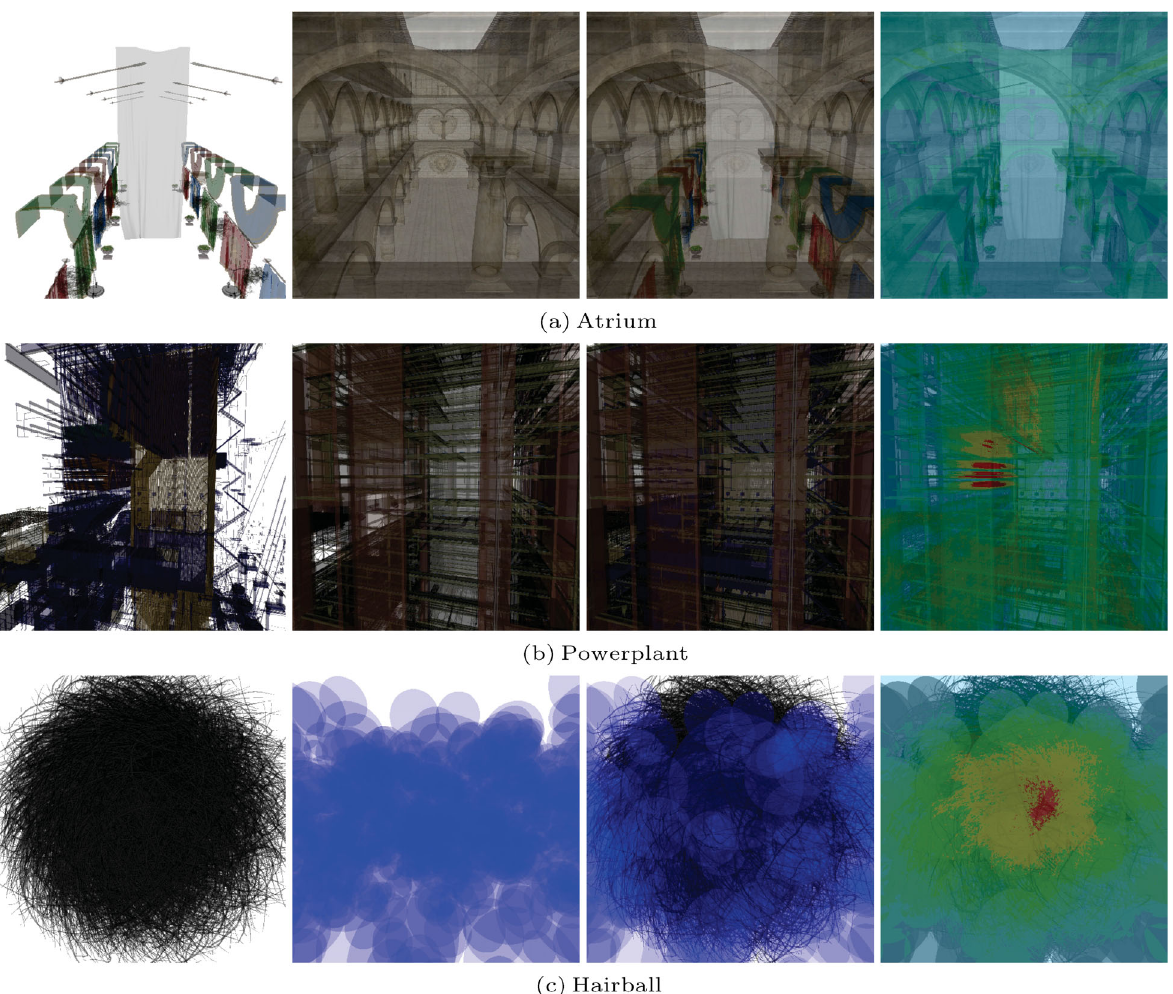
Fig. 8 Test scenes with separated and merged deep images. Heatmap gives depth complexity with blue up to 16 fragments, green 16–64, yellow 64–128, and red